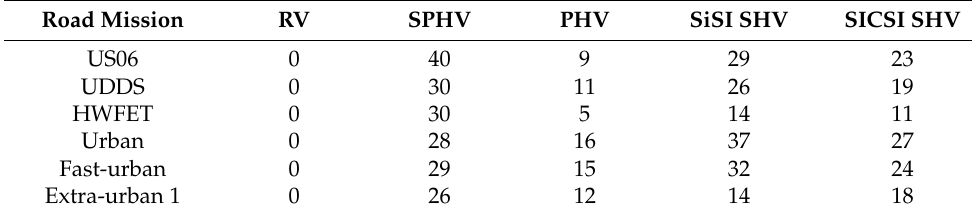
Table 14. Specifical electrical losses. (Wh/Km).